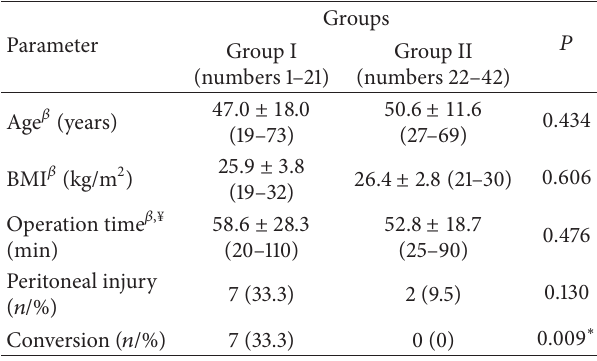
Table 2: Demographic and operative data of the